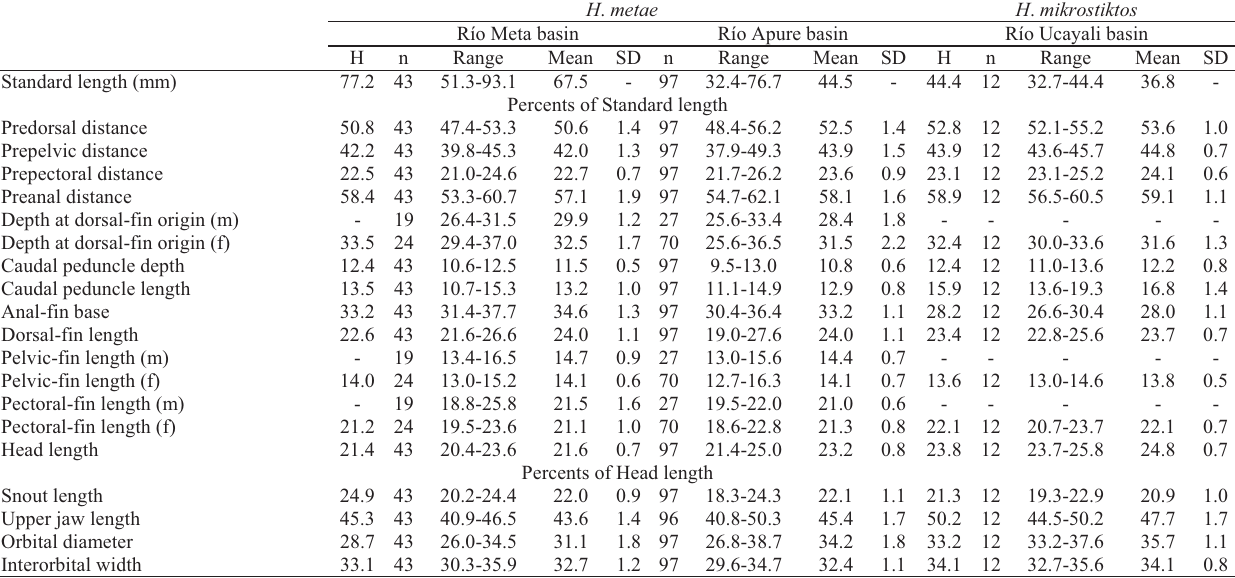
Table 4. Morphometric data of holotype (H) of Hemibrycon metae (CAS 123727), and non-types from río Meta basin, Colombia (IAvHP 2973, 3122, 3322, 3628, 3632), and from río Apure basin, Venezuela (INHS 27766, 31851, 61270; MCNG 98, 5646, 6759, 7923; NRM 23991, 23993), all from río Orinoco basin; and holotype (MUSM 35490) and paratypes (MCP 44521, MUSM 15845, UFRGS 12003, all unsexed) of Hemibrycon mikrostiktos from the upper río Ucayali basin, Peru. m, males; f, females. SD = Standard